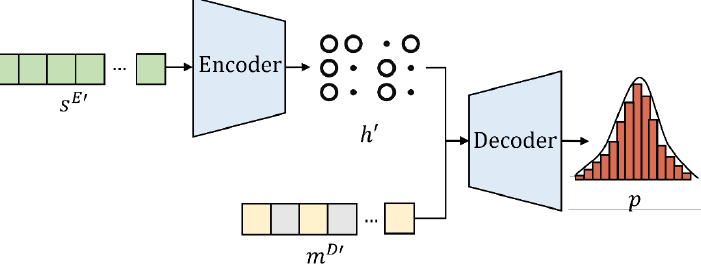
Figure 10. Seq2Seq model executer for the execution phase.